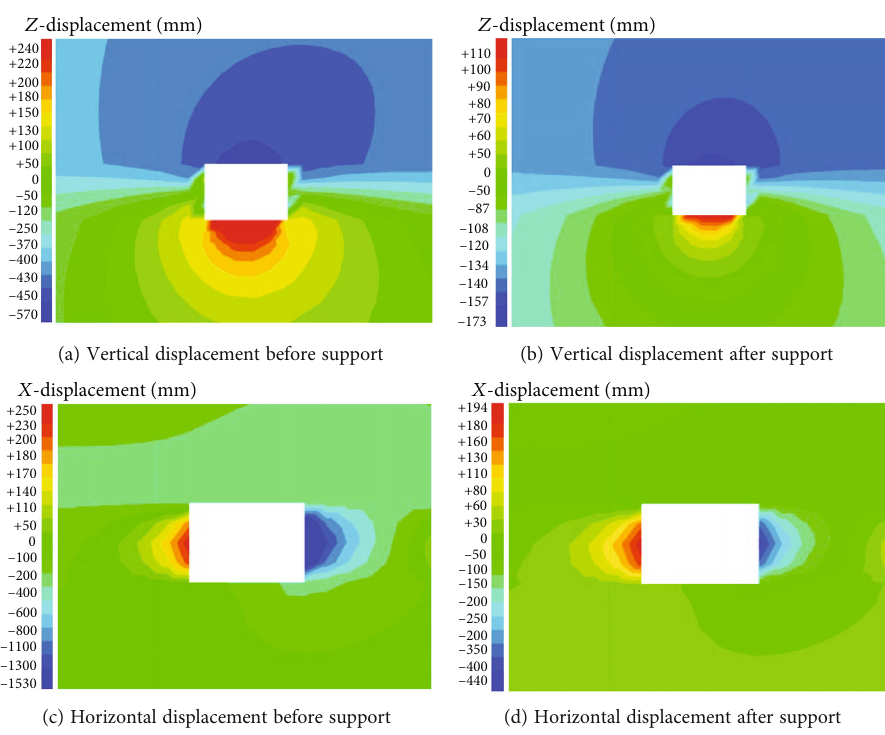
Figure 11: Displacement of roadway before and after support. (a) Vertical displacement before support. (b) Vertical displacement after support. (c) Horizontal displacement before support. (d) Horizontal displacement after support.